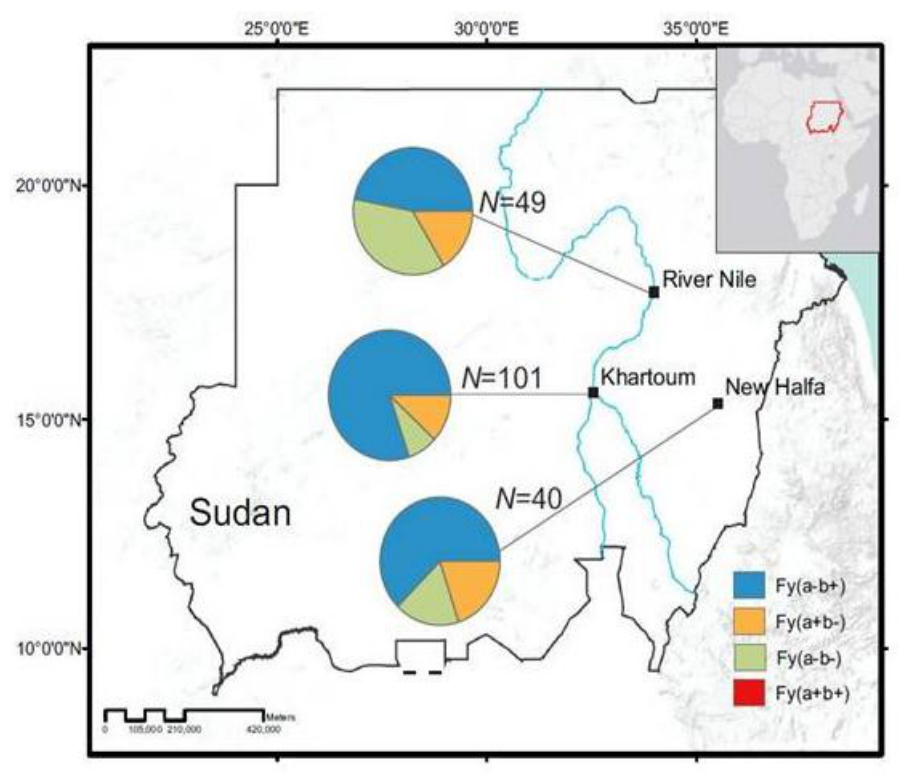
Figure 1. Proportion of Duffy phenotypes in Plasmodium positive patients among the three sites in River Nile, Khartoum, and New Halfa. The proportion of Fy(a-b-) was significantly higher in River Nile than the other two sites. In addition, Fy(a+b+) was not recorded in any of the healthy or Plasmodium -positive patients.